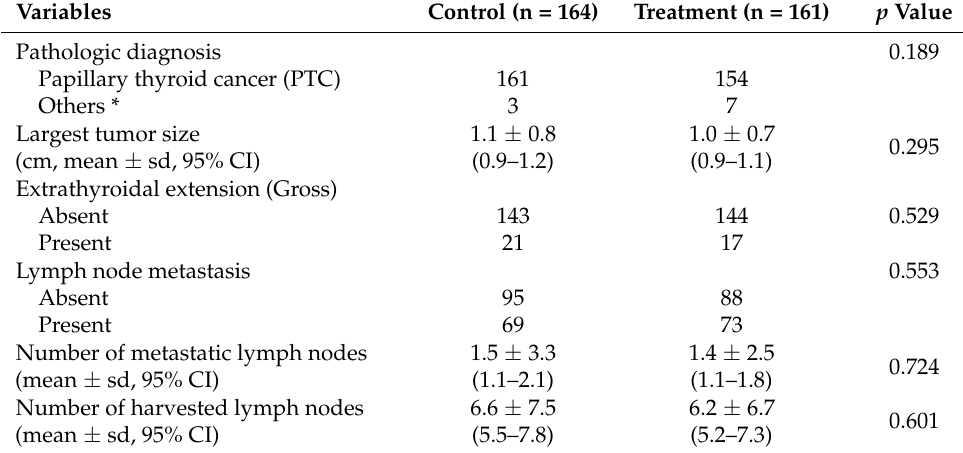
Table 2. Pathologic findings.